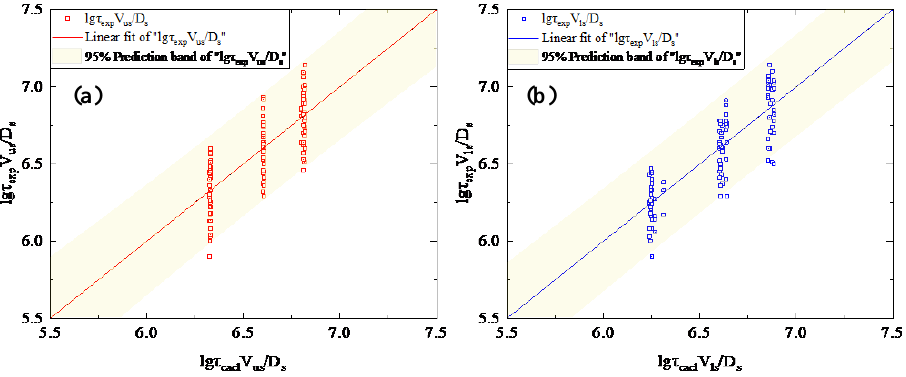
Figure 9. Comparison of experimental lg τ V s / D s with calculated ones for upper side nozzle ( a ) and lower side nozzle ( b ), respectively, using proposed Equations (19) and (20).